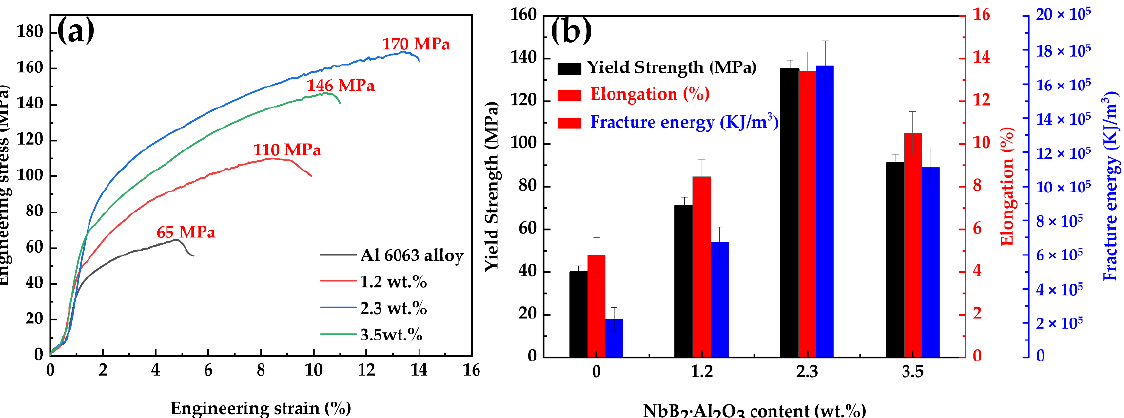
Figure 9. Composite properties with varying particle contents: ( a ) the stress–strain curve and ( b ) the yield strength, elongation, and toughness.